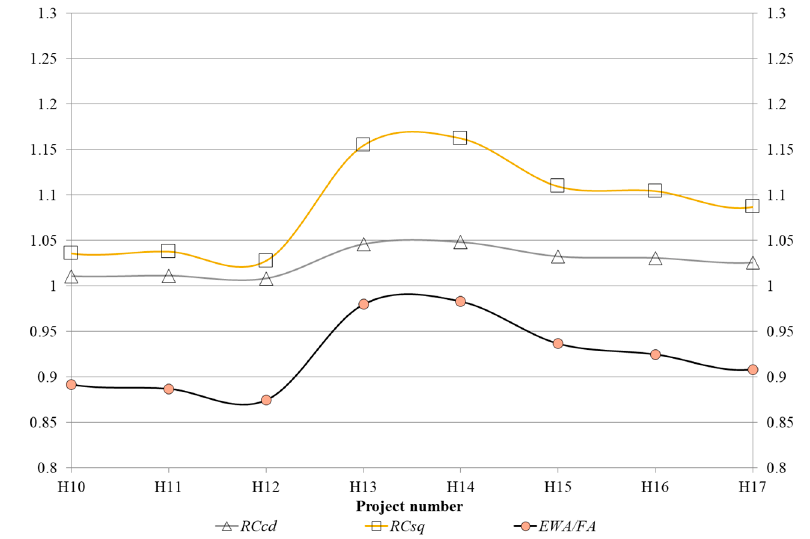
Figure 6. An almost perfect correlation between the RC cd and EWA / FA indicators at the level cor( RC cd , EWA / FA ) = 0.9832 in the limited range of the H10–H17 area variation (Table 1).